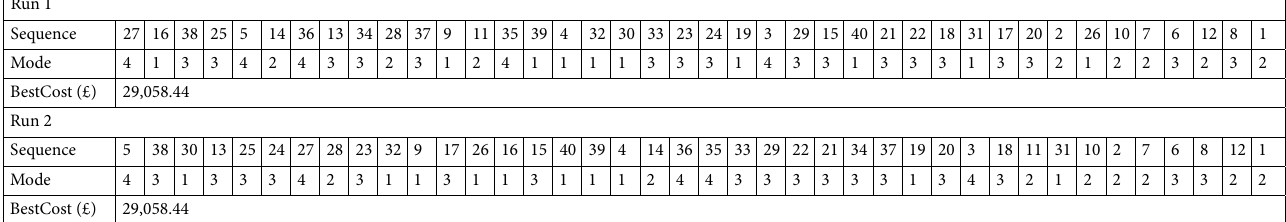
Table 1. DMM algorithm output and